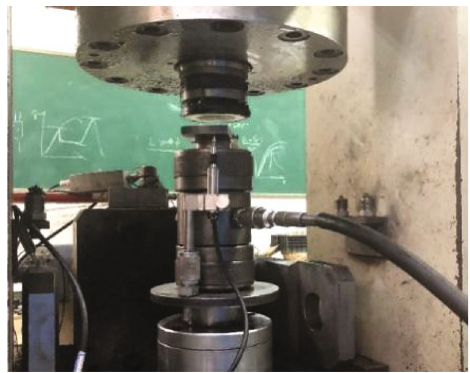
Figure 1: Conventional triaxial compression test.